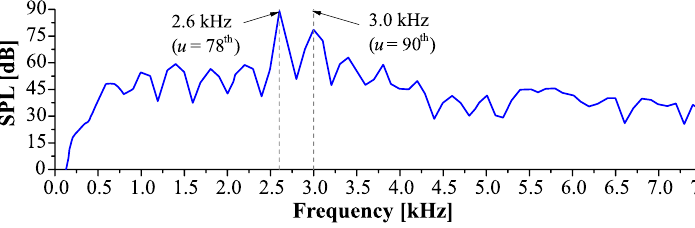
Figure 14. Sound pressure level of the baseline 8/6 SRM at 2000 rpm.